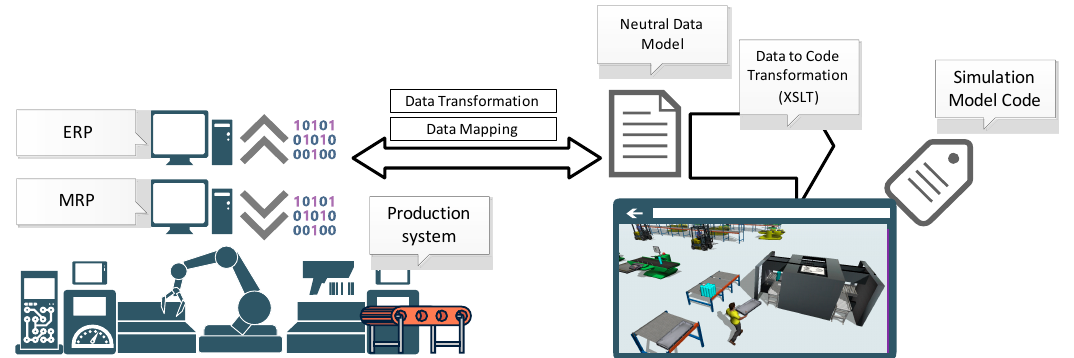
Figure 1. The simulation model generation process.